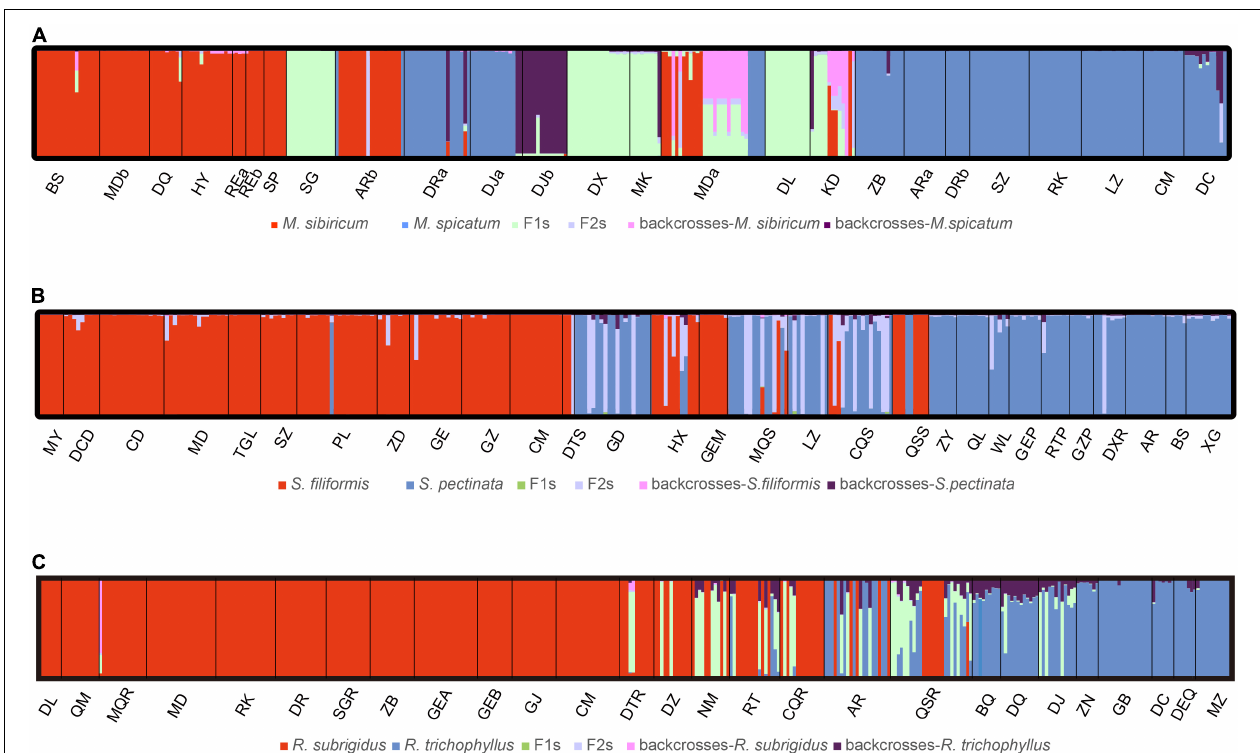
FIGURE 4 | The results of the NewHybrids analysis for all species pairs based on microsatellite data. (A) Myriophyllum , (B) Stuckenia , and (C) Ranunculus . The vertical bars display the probability of assignment to six membership classes: two parents, F1s, F2s, and backcrosses to each parent.